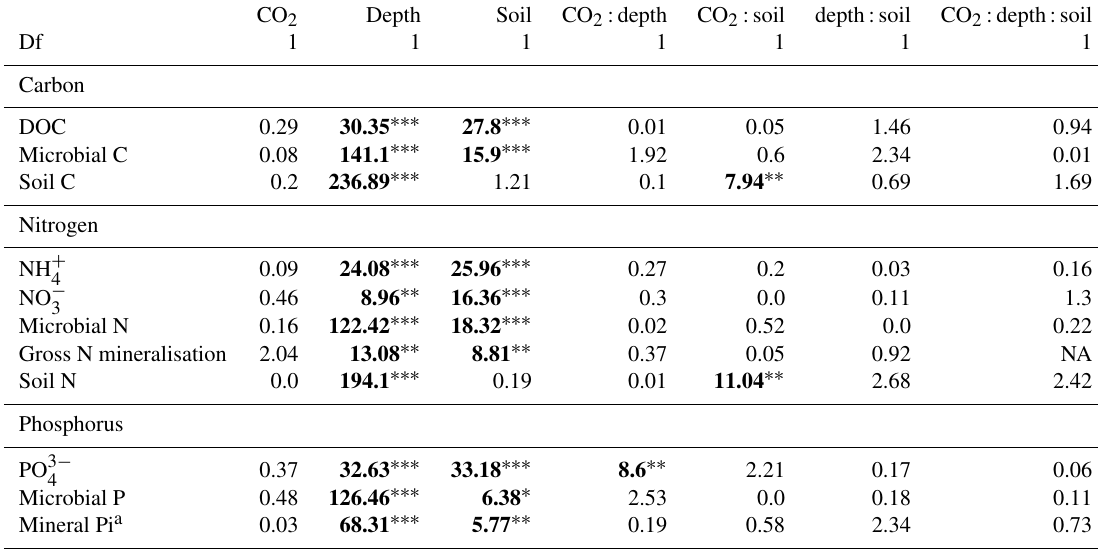
Table 1. The effect of the factors CO 2 ( e CO 2 and e CO 2 ), soil depth (0–10 and 10–30cm and transition), and soil type (bulk and rhizosphere soil) and their interactions, shown as a model F statistic output. Asterisks and bold typeface indicate the level of significance of P values, with ∗∗∗ for P< 0 . 001, ∗∗ for P< 0 . 01, and ∗ for P< 0 . 05. The extractable nutrients NH + C, N, and P are modelled on a milligram per kilogram (mgkg − 1 ) basis, the gross N mineralisation rate on a milligram per kilogram per day (mgkg − 1 d − 1 ) basis, and soil C and N in percent. Note that Df is for degrees of freedom.